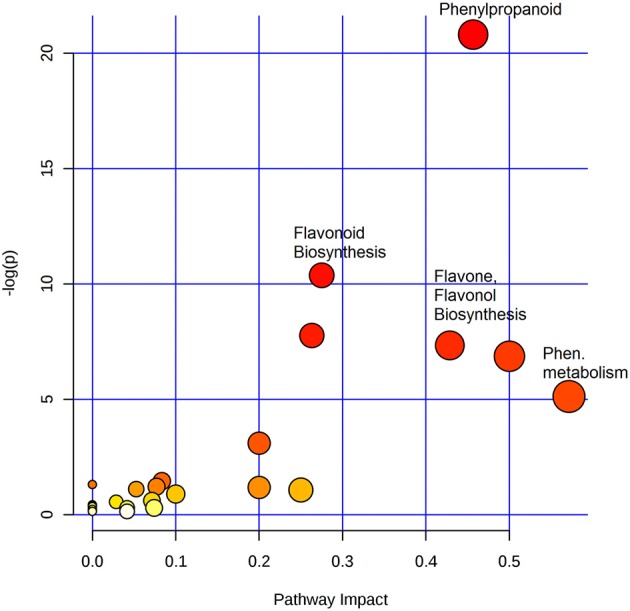
Summary of pathway analysis with MetPA: Representation of all MetPA-computed metabolic pathways displayed according to their significance or pathway impact. The graph, presents a view of all the matched pathways arranged by p-values (pathway enrichment analysis) on the y-axis, and the pathway impact values (pathway topology analysis) on the x-axis. The node color (beige to red) is based on the node's p-value and the node radius is defined by the pathway impact values. The latter is the cumulative percentage from the matched metabolite nodes, and the maximum importance of each pathway is 1. Thus, the graph indicates pathways with high impact: phenylalanine metabolism, phenylpropanoid-, flavonoid-, flavone- and flavonol-biosynthesis, to be highly significant metabolic pathways that are involved in the sorghum response to C. sublineolum infection.